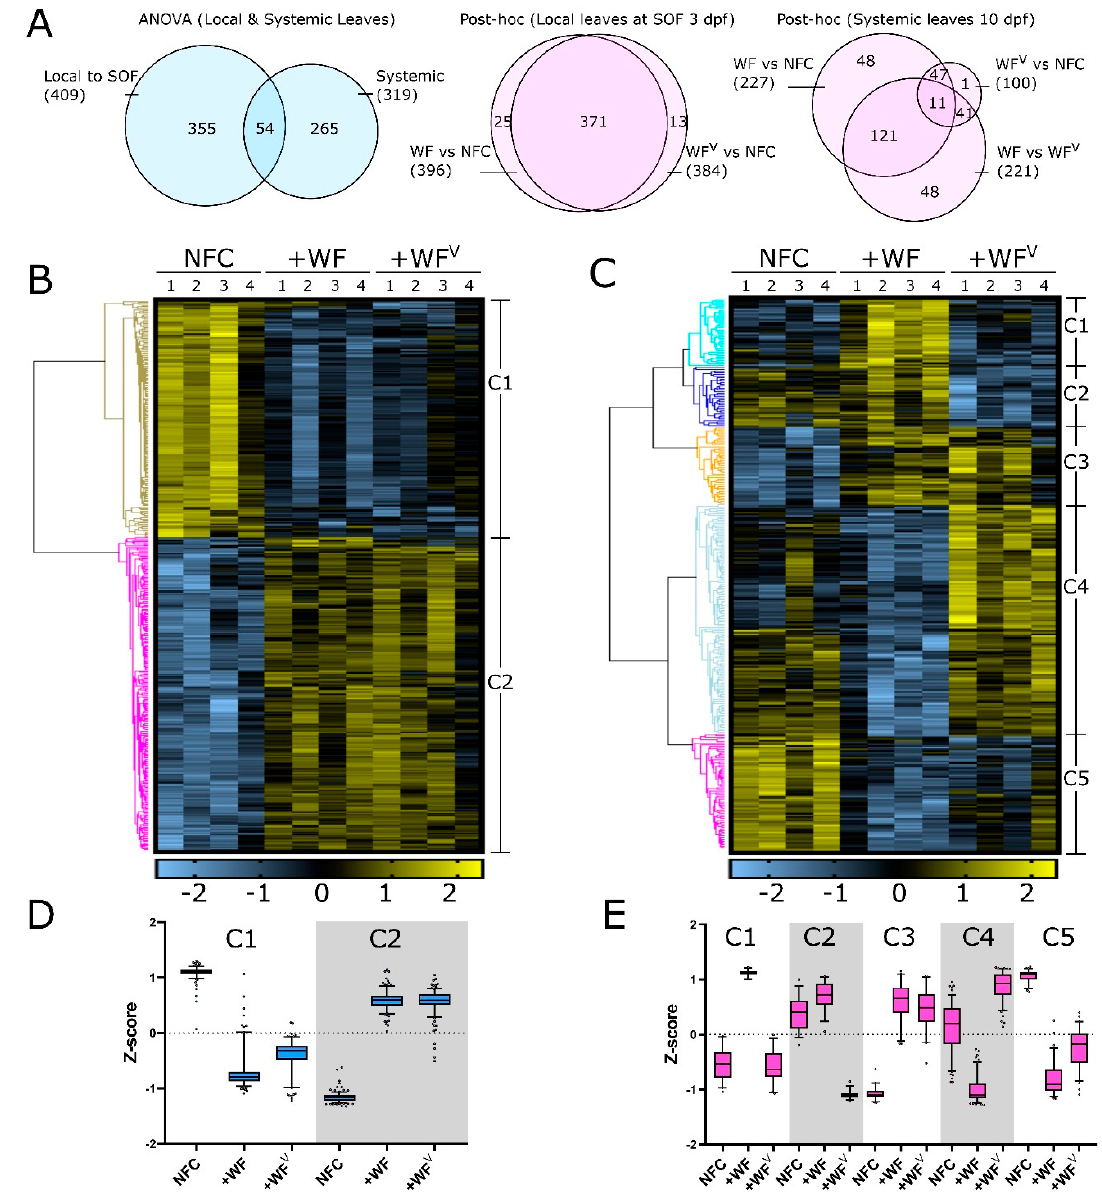
Figure 3. ( A ) Venn diagrams depicting number of proteins significantly changed in both local and systemic leaves by ANOVA (left, blue), as well as using pairwise post-hoc comparisons of treatments at the SOF 3 dpf (pink, middle) and in systemic leaves 10 dpf (blue, right). ( B , C ) Heat maps of hierarchical clustering analysis using z-score transformed data for local leaves 3 dpf ( B ) and systemic ( C ) leaves 10 dpf. ( D , E ) Cluster trends for both local ( D ) and systemic ( E ) leaves. Error bars represent the 5-95% z-score range for each sample. WF, whitefly; WF V , viruliferous whitefly; NFC, no-feeding control; SOF, Sight of feeding; C, Cluster.